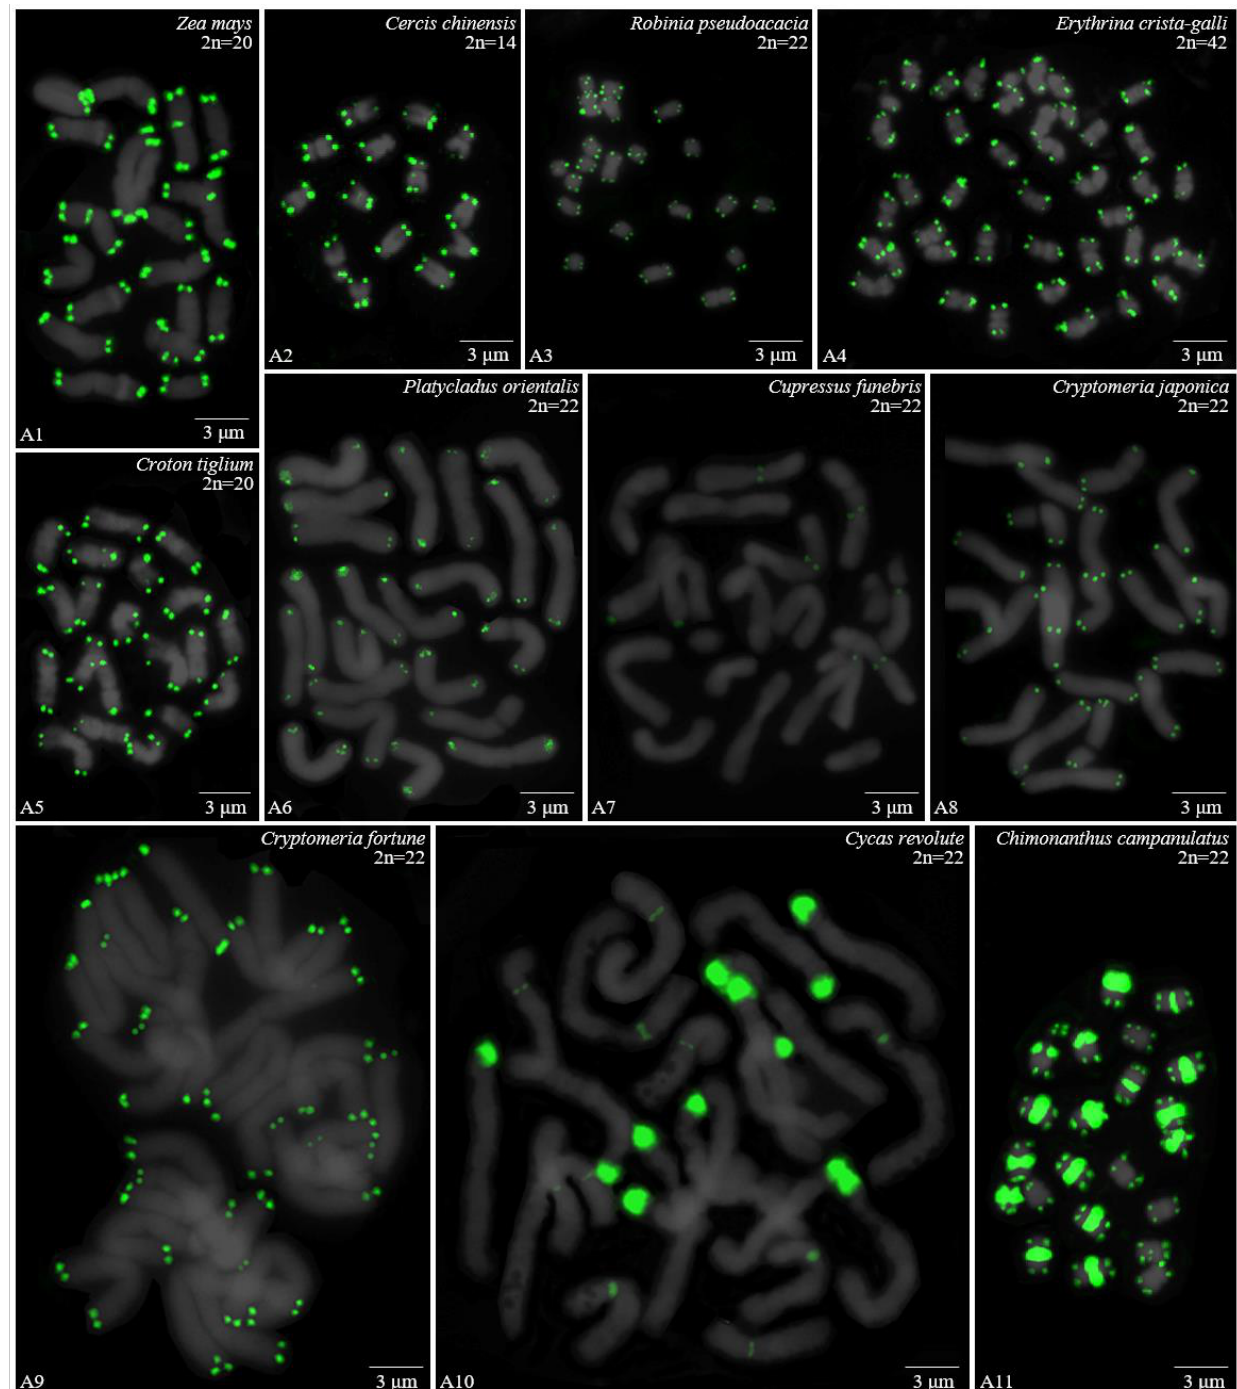
Figure 1. Oligo-FISH depicting the (AG 3 T 3 ) 3 present in Z. mays and ten woody plants. Chromosomes in A1–A8 and A11 are from metaphase, while the chromosomes in A9–A10 are from prometaphase. Oligo-probe (AG 3 T 3 ) 3 is exhibited by green signals: ( A1 ) Z. mays , 2n = 20; ( A2 ) C. chinensis , 2n = 14; ( A3 ) R. pseudoacacia , 2n = 22; ( A4 ) E. crista-galli , 2n = 42; ( A5 ) C. tiglium , 2n = 20; ( A6 ) P. orientalis , 2n = 22; ( A7 ) C. funebris , 2n = 22; ( A8 ) C. japonica , 2n = 22; ( A9 ) C. fortunei , 2n = 22; ( A10 ) C. revoluta , 2n = 22; and ( A11 ) C. campanulatus , 2n = 22. Bar: 3 μm.